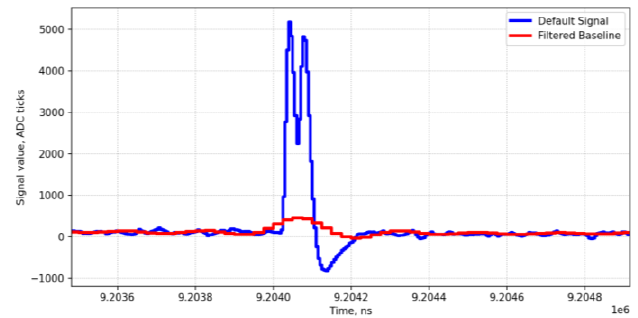
Fig. 9. Median filter response to a pileup of equal pulses (window width